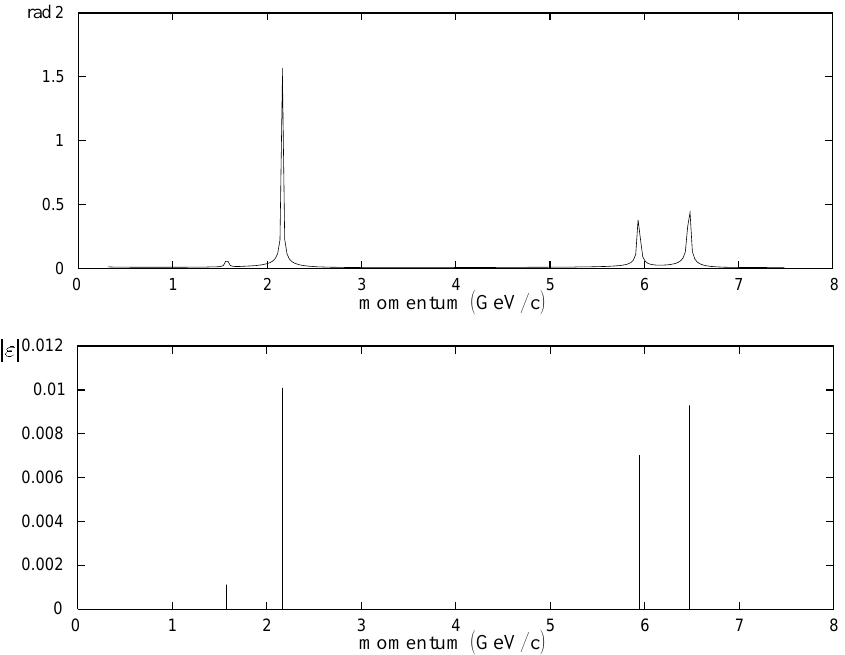
FIG. 1. SLIM opening angles of (cid:2) n (cid:2) (cid:2) z (cid:3) (top) and resonance strength (bottom) for a beam with normalized vertical emittance of 4 p mmmrad in DESY III.